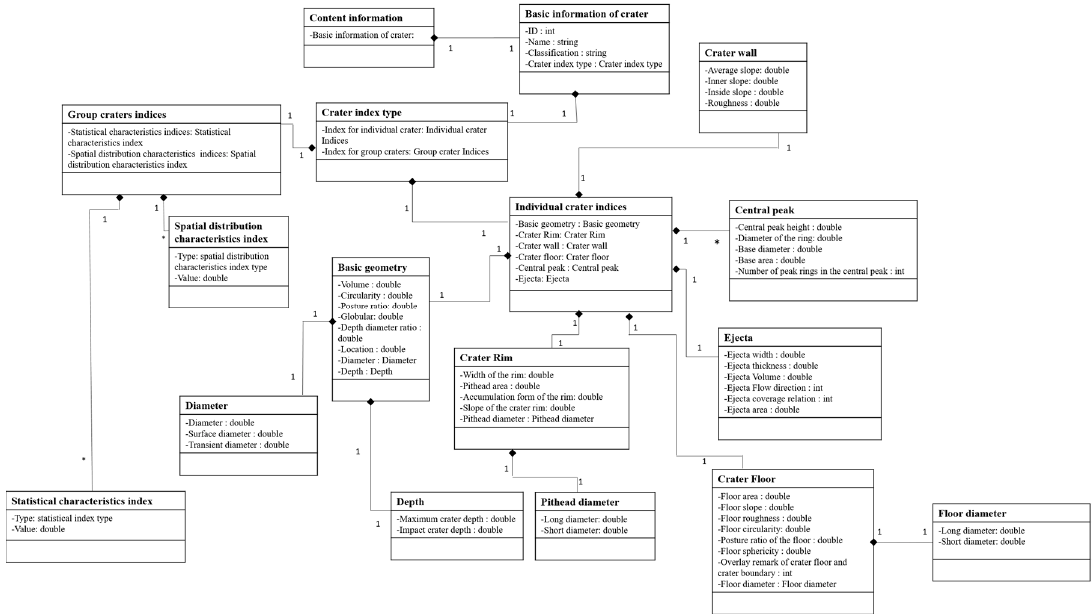
Figure 14. UML for the content organisation of descriptive indices.